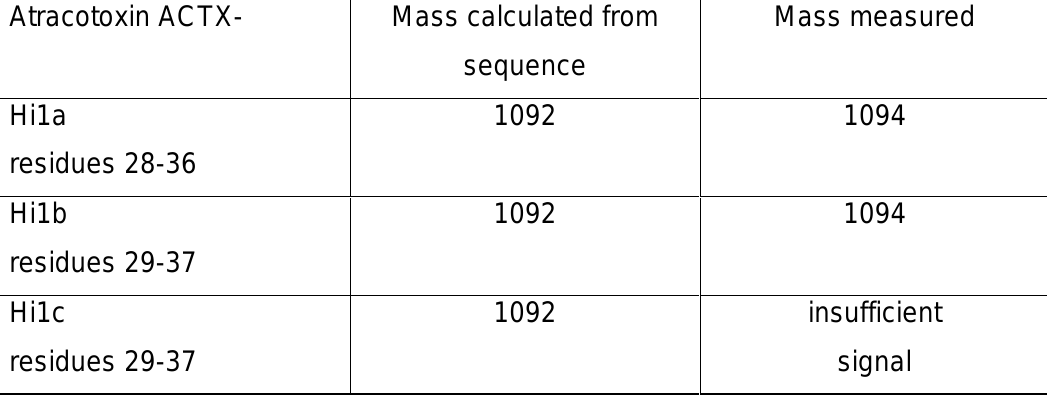
Table 3.2: Plasma desorption mass spectrometry results of fragments from endopeptidase Glu-C cleavage of reduced and alkylated